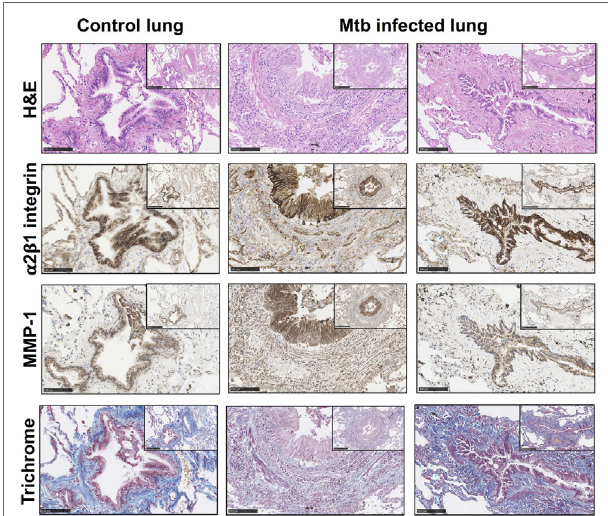
FigUre 4 | Matrix metalloproteinases (MMP)-1 is further increased in lung tissue sections with altered collagen staining from Mtb-infected patients. Paraffin-embedded lung tissue blocks from Mtb ( n = 5) and control ( n = 2) patients were sectioned into 5 µm slices and stained for Hematoxylin and Eosin (H&E), integrin α 2 β 1 (1/500 anti- α 2 antibody, clone EPR5788) (brown), MMP-1 (1/600 anti-MMP-1 antibody, clone 41-1E5) (brown), and modified Trichrome stain, which stains collagen (blue). Sections were inspected by a “blinded” reviewer and five airways from each individual were randomly selected for visual analysis. Staining of α 2 β 1 (brown) was similar between Mtb patients and controls but MMP-1 (brown) is increased in Mtb patients. This figure shows representative images from a control lung (left panels) and two Mtb lungs (middle and right panels). Images are shown at 20 × with inset shown at 10 × magnification. Images were analyzed with the NDP. viewer software. Scale bars: 250 µm for images at 10 × and 100 µm for images at 20 ×